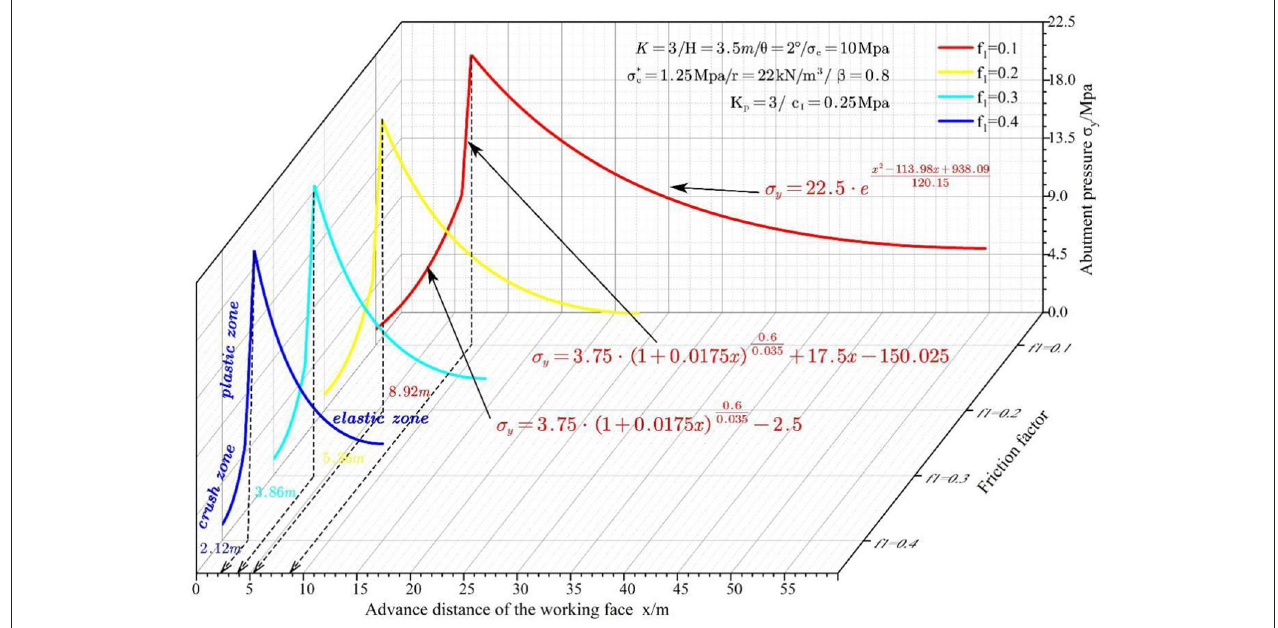
FIGURE 7 | Impacts of friction coefficient on abutment pressure.